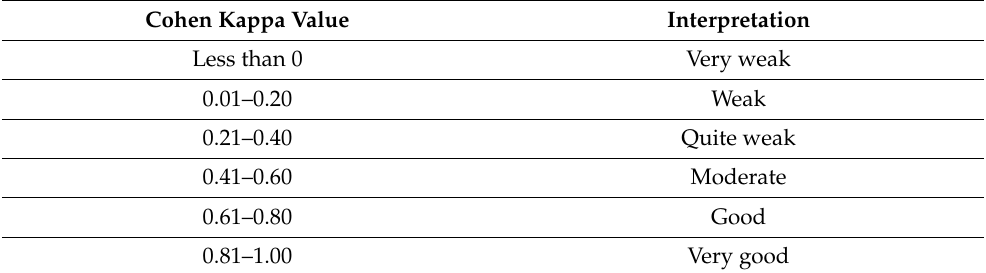
Table 2. The interpretation of the Cohen Kappa value.